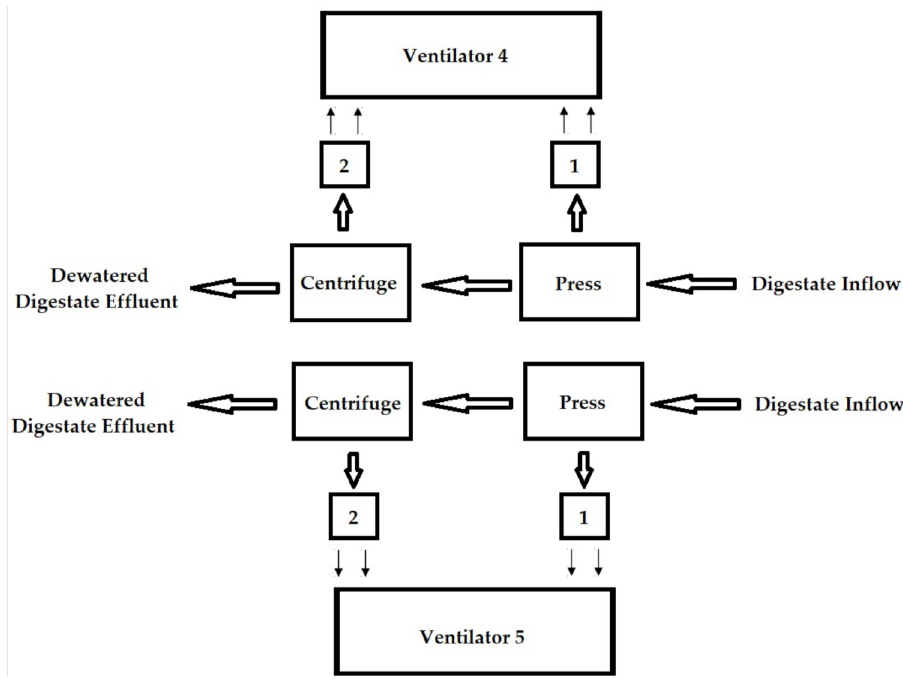
Figure 2. Scheme of the digestate dewatering hall at the MWBP (1—press effluent tank, 2—centrifuge effluent